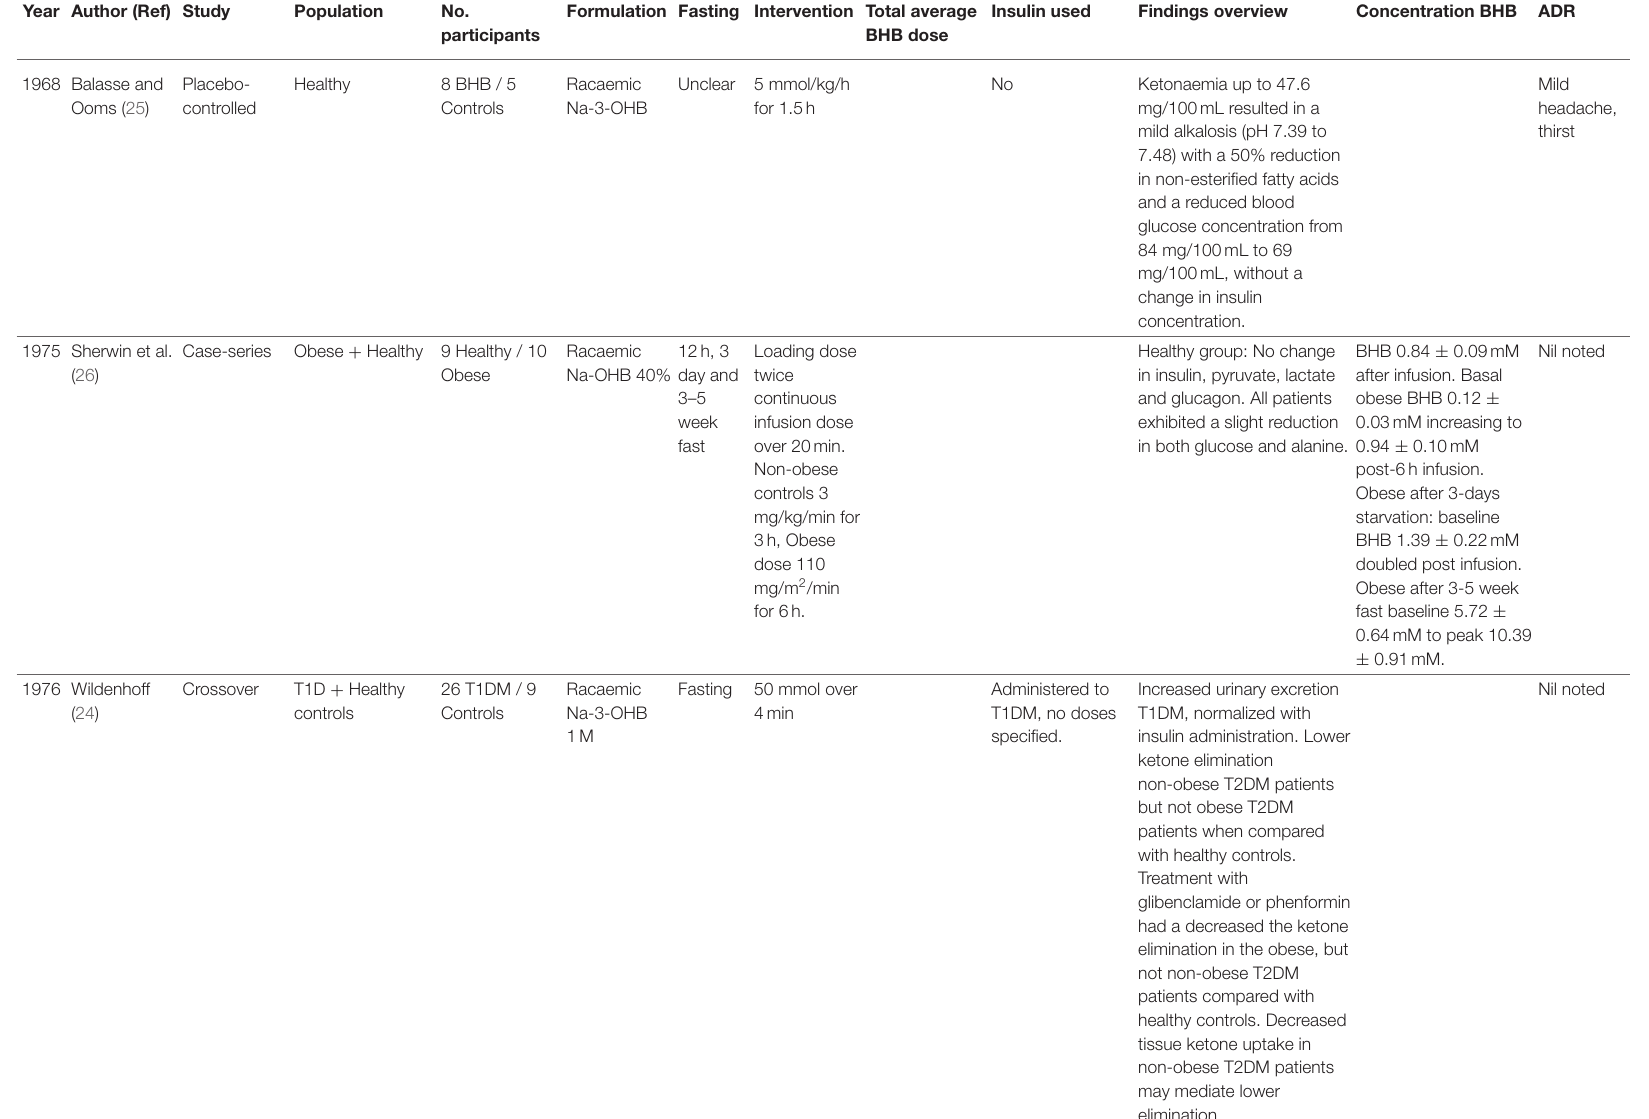
TABLE 3 | Ketone studies with metabolic